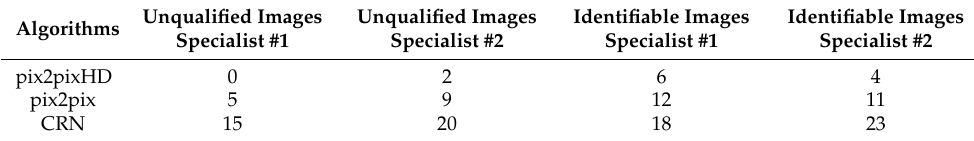
Table 2. Comparisons of pix2pixHD against other state-of-the-art algorithms. Unqualified Images Algorithms Specialist